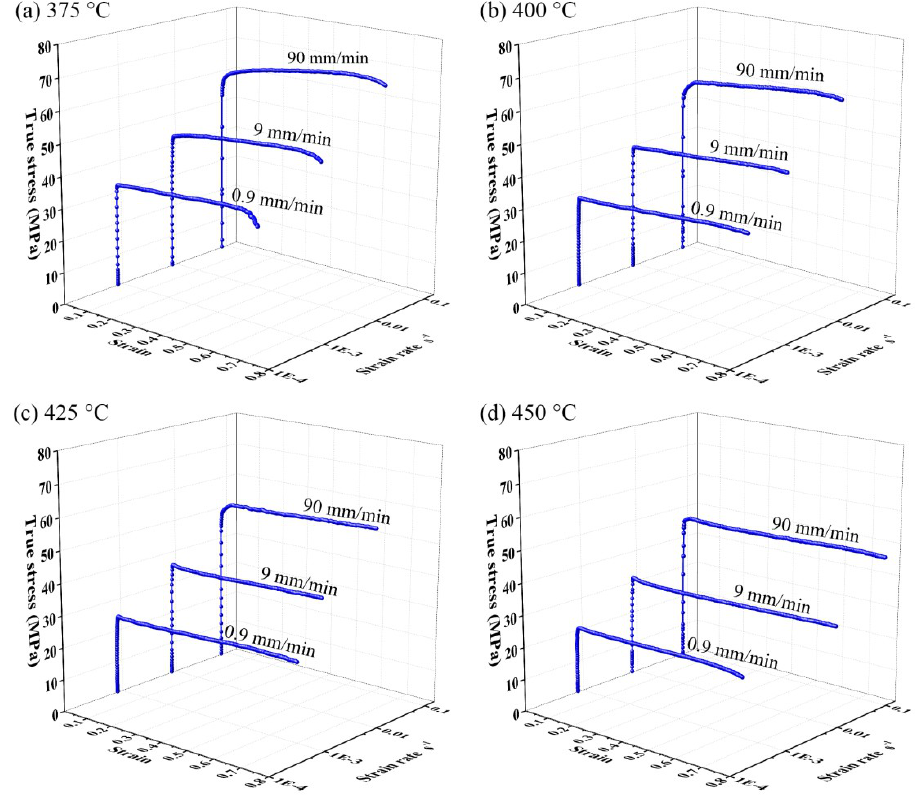
Figure 7. Stress-strain curves of specimens deformed at different temperatures and crosshead speeds: ( a ) 375°C; ( b ) 400°C; ( c ) 425°C; ( d ) 450°C.